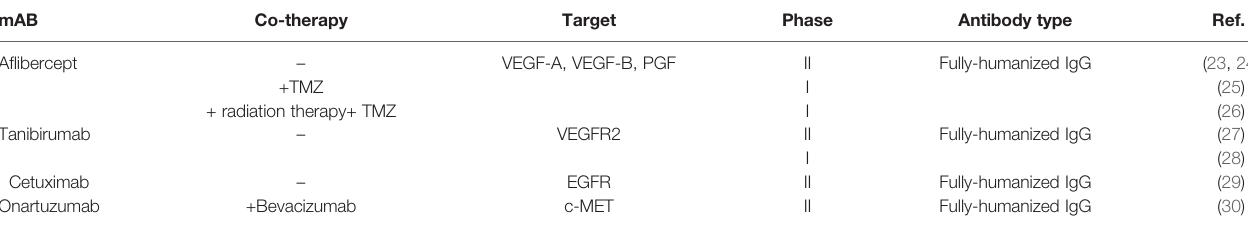
TABLE 2 | Clinical trials on mAbs/fusion proteins for